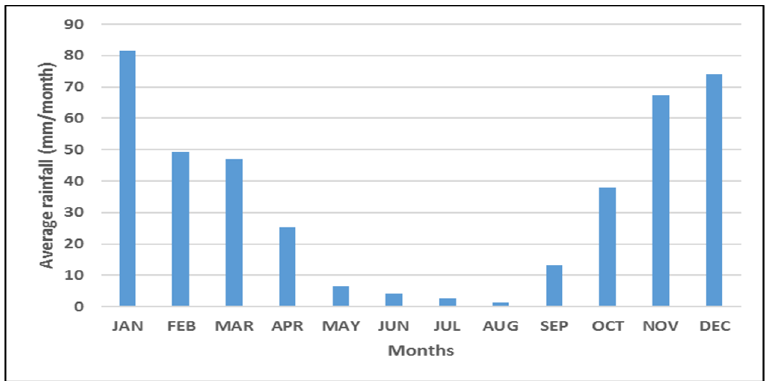
Figure 3. Mean monthly average rainfall in the IUWMA (1972–2020).